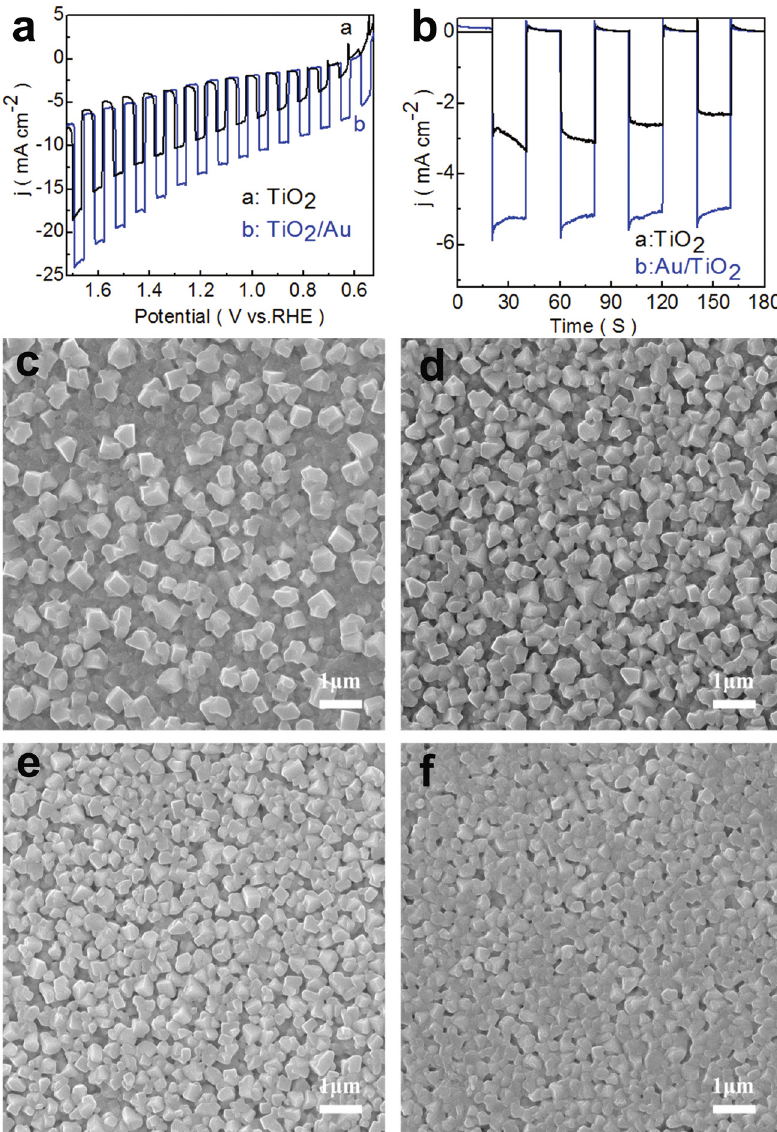
Figure 10: ( a and b ) Chopped illumination linear sweep voltammograms ( a ) and time domain photocurrents ( b ) of Au/TiO 2 NP - modi fi ed electrode in 0.1 M Na 2 SO 4 aqueous solution, with pH adjusted to 11 by adding NaOH solution. Reproduced with permission [ 171 ] . Copyright 2018, American Chemical Society. ( c – f ) Top views of SEM images of a CH 3 NH 3 PbI 3 perovskite fi lm ( a ) without and with ( b ) 0.5 vol%, ( c ) 1.0 vol%, and ( d ) 1.5 vol% Au@Ag@SiO 2 NCs addition. Reproduced with permission [ 108 ] . Copyright 2019,